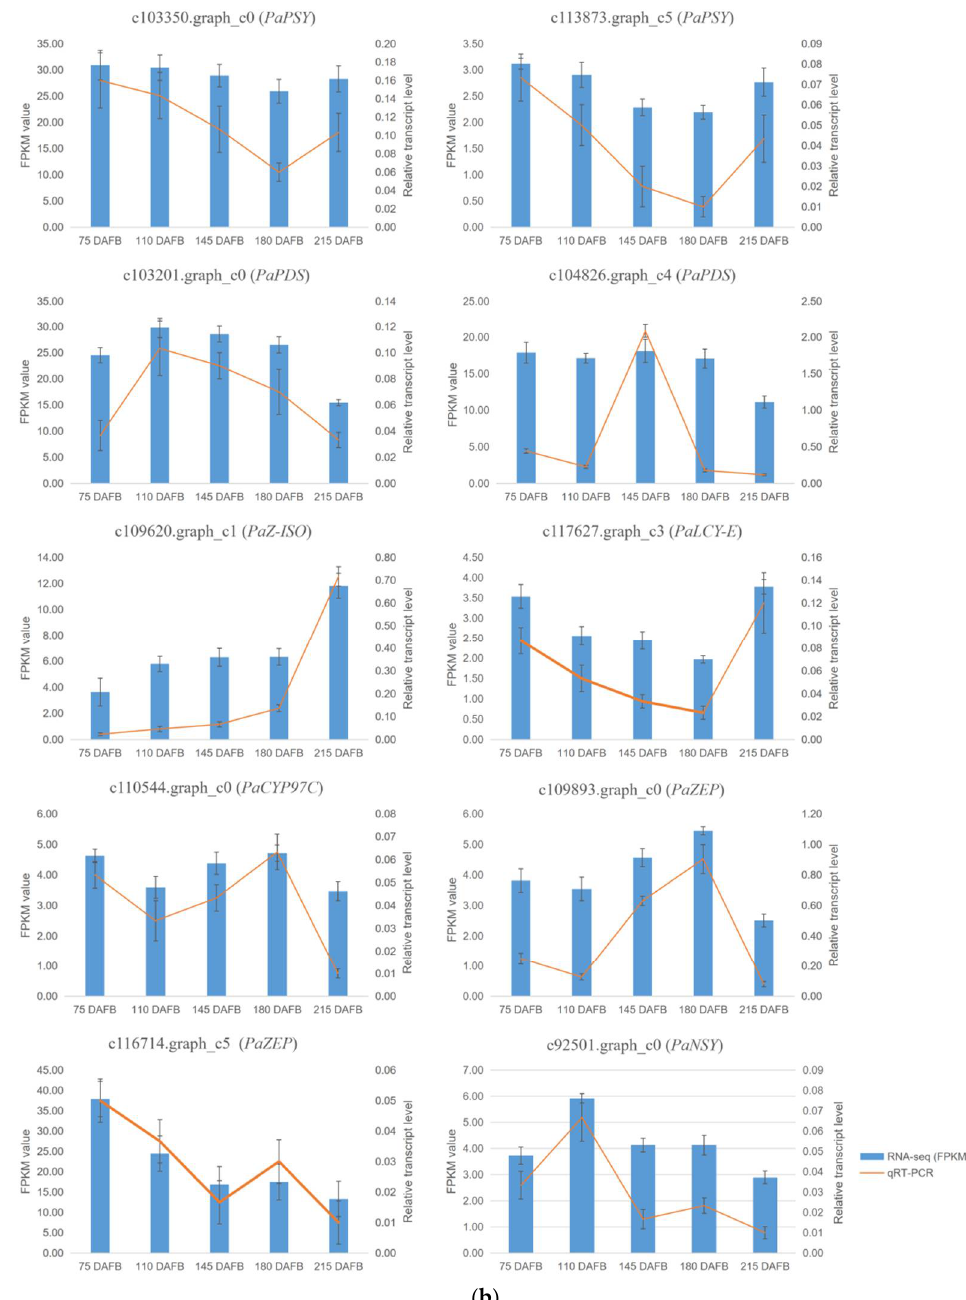
Figure 5. The FPKM values and relative expression levels of 10 carotenoid biosynthesis unigenes in avocado mesocarp ( a ) and seed ( b ). Error bars are standard errors of the mean from three biological replicates and two technical replicates.